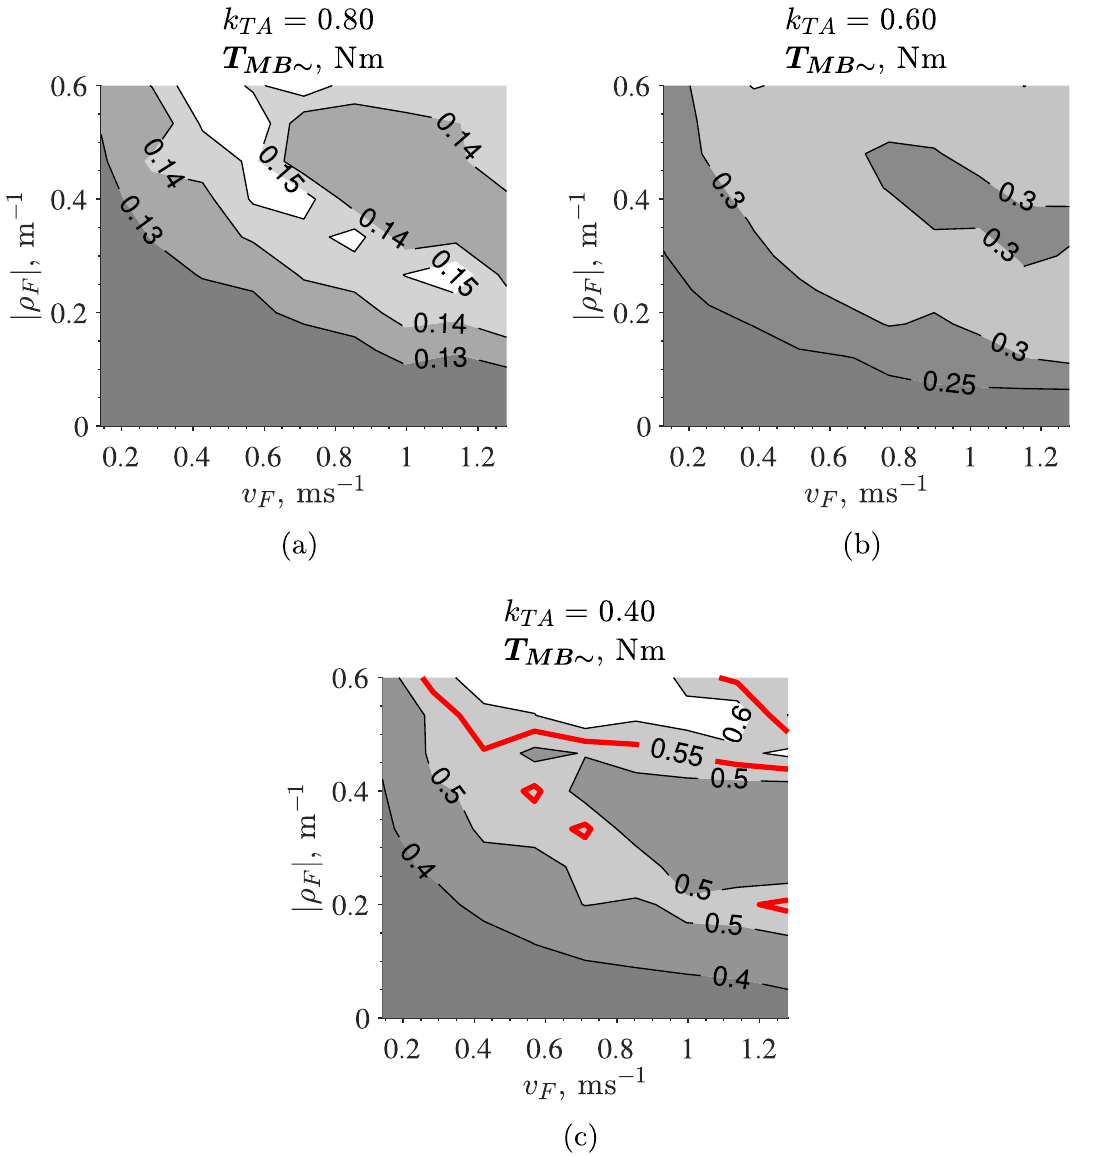
Fig. 17 Mapping of the rear motors torques at steady state circular manoeuvring with different traction allocation ratio k TA . The solid red line highlights the motor nominal torque of